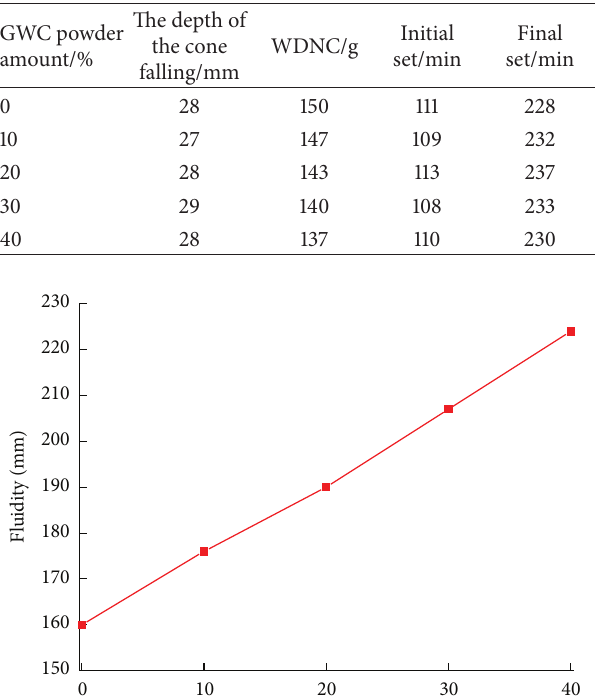
Table 1: WDNC and setting time of cement with different amounts of the GWC powder.